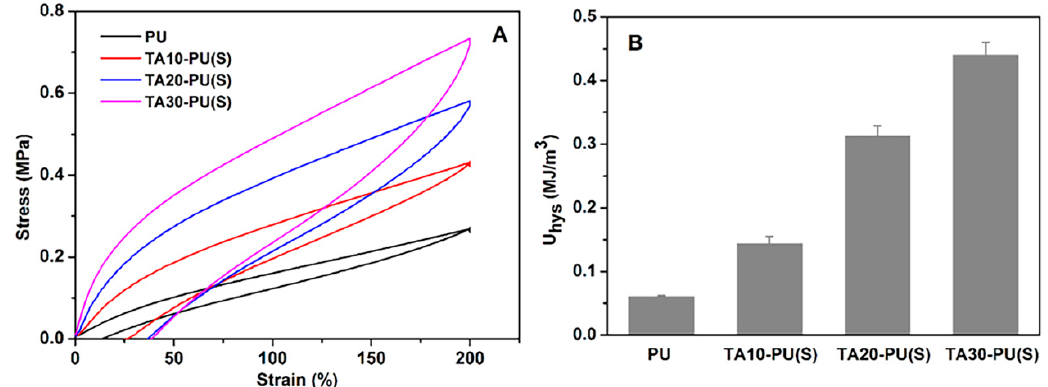
Figure 7 . Stress–strain curves from loading–unloading tests ( A ) and calculated dissipated energy ( B ) of pure PU and TAx–PU(S) hydrogels under 200% of strain.